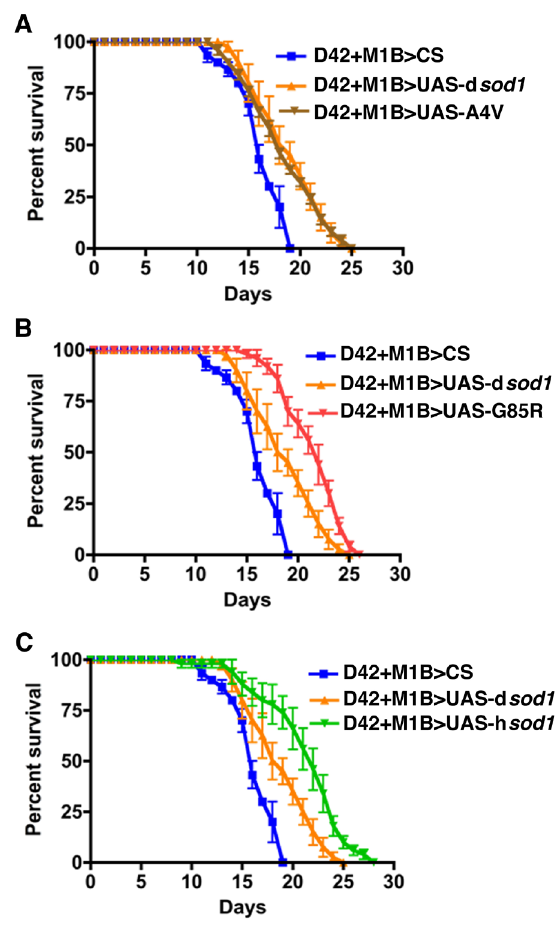
Figure 5. Human SOD1 co-overexpressed in motoneurons and glial cells and treated with 3 mM BMAA. Shown are survival rates of 5 day- old male sod1 transgenic flies (10 flies per vial). Panels A , B , and C represent flies expressing mutant human A4V, G85R, and wild type SOD1 proteins and control flies (D42+M1B>CS and D42+M1B>UAS-d sod1 ) in motoneurons and glia using D42-Gal4, M1B-Gal4, respectively. At the 50% survival rate, the longevity for A4V, G85R, and hSOD1 is increased by 0%, 17%, and 22% for A4V, G85R, and hSOD1 flies, respectively, compared to D42>UAS-d sod1 and D42>CS. Differences were considered statistically significant if p<0.05 and were calculated by a paired t-test method using Prizm software (n=50 for each